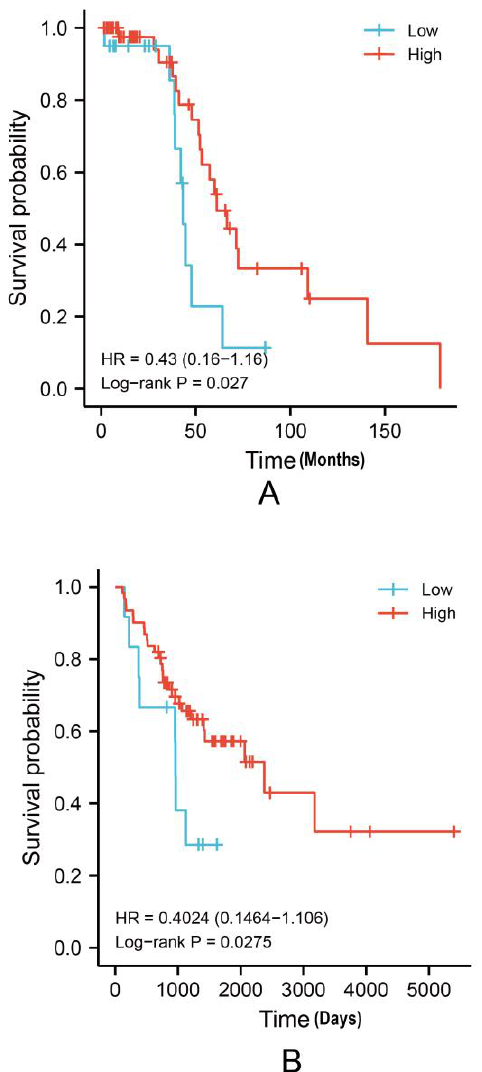
Figure 3. Kaplan–Meier analysis according to low and high EPHA3 expression levels in GSE48075 Figure 3. Kaplan – Meier analysis according to low and high EPHA3 expression levels in GSE48075 ( A , p = 0.027) and GSE48276 ( B , p = ( A , p = 0.027) and GSE48276 ( B , p = 0.0275).